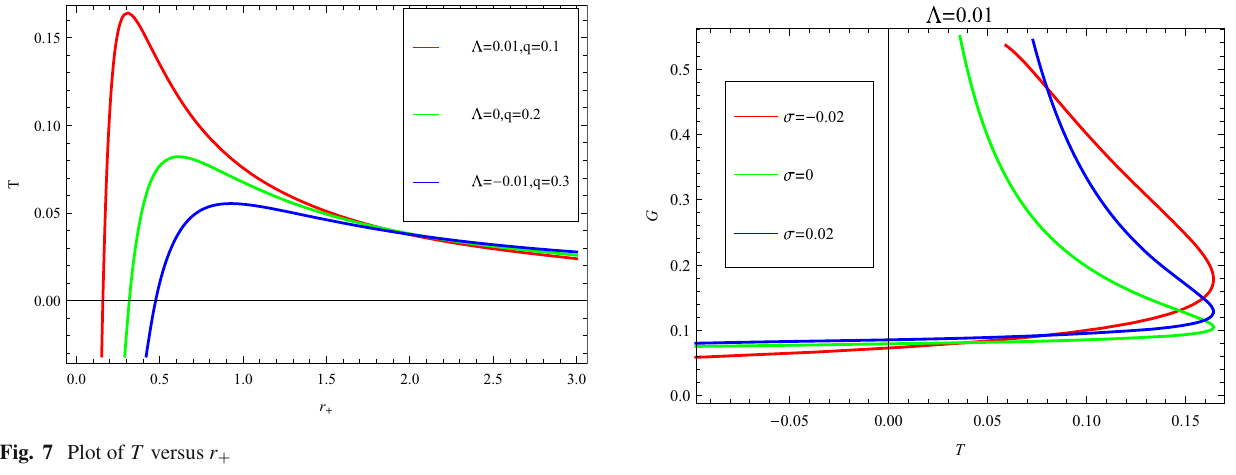
Fig. 8 Plot of G versus T of the RBH with cosmological constant in NED 0 . 1 ≤ r ≤ 0 . 4 but it starts decreasing when r ≥ 0 . 4. In the absence of cosmological constant, the temperature increases for 0 . 3 ≤ r ≤ 0 . 5 but when it reaches at r = 0 . 5 it bounces back and starts decreasing. For negative cosmological con- stant, the temperature is increasing for the small values of horizon radius while it starts decreasing when r ≥ 1 . 0. The temperatures almost approach to the same value when r = 2 . 0 but not for r ≥ 2 . 0. When we rewrite Eq.(14) as Eq.(22), which is the modi- fication of the first law of thermodynamics at horizon of the RBH with cosmological constant, the surface tension at the horizon becomes